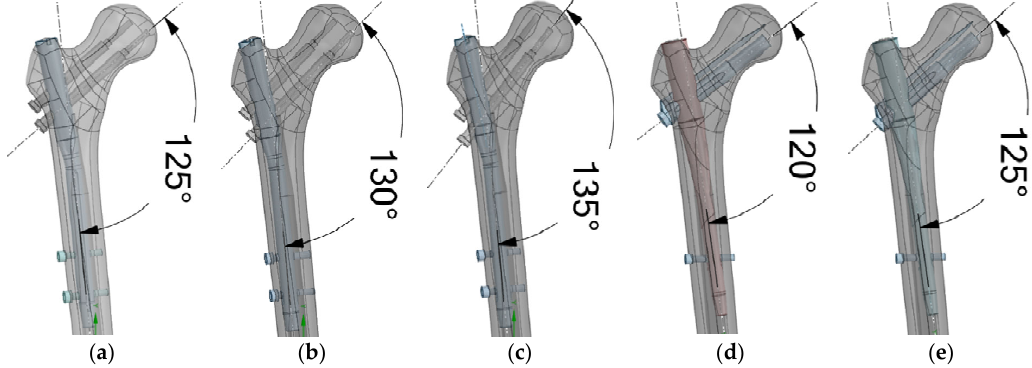
Figure 6. Modified CAD models of a healed femur with nails—( a – c ) Medin; ( d , e ) Tantum.